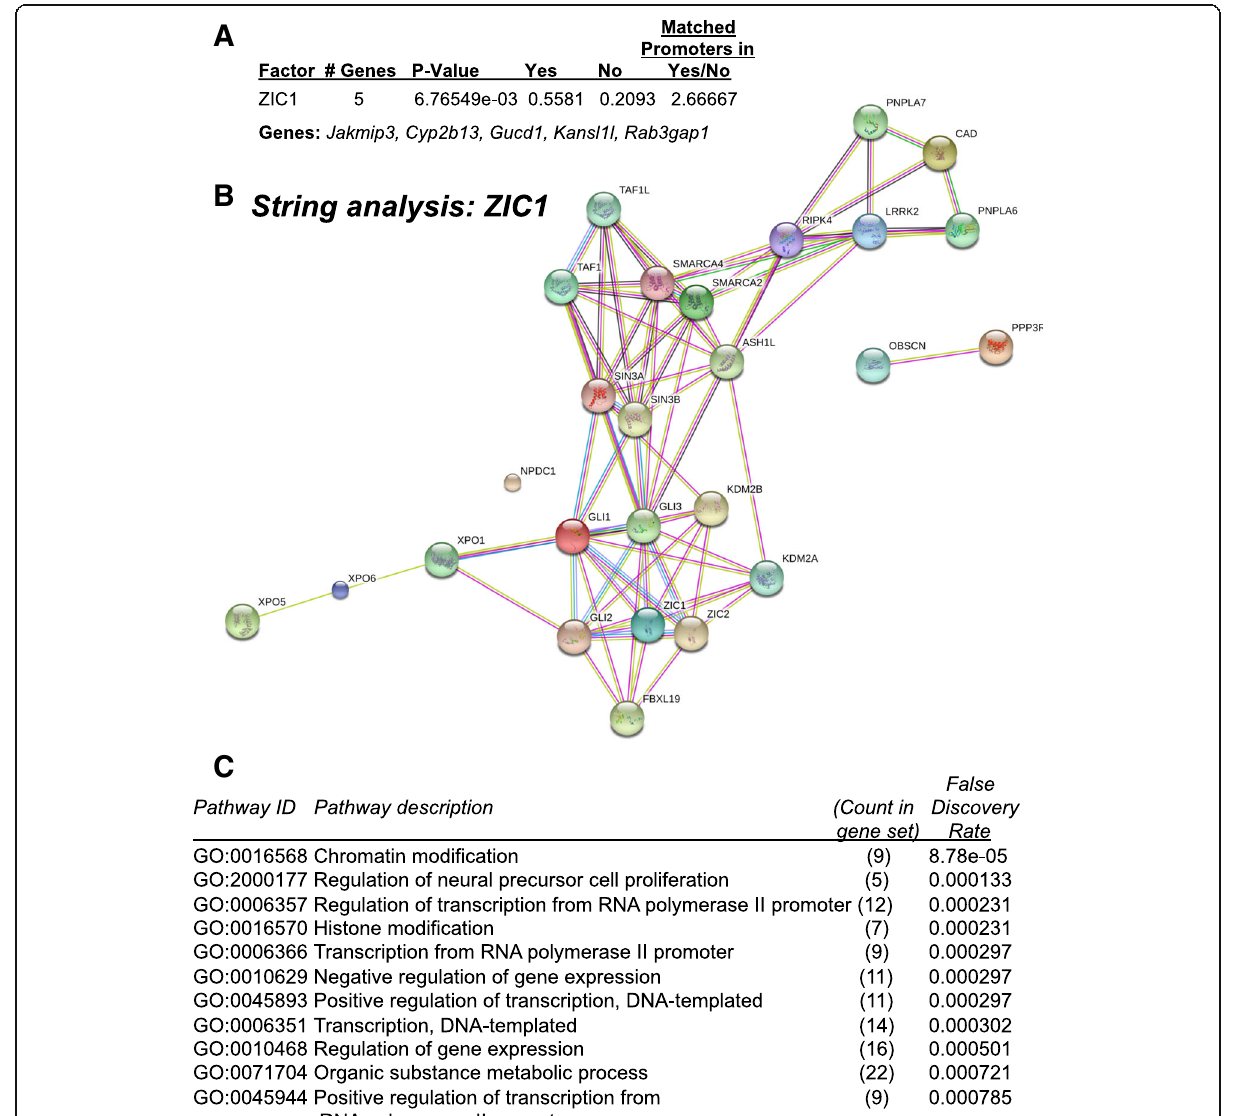
Fig. 4 Functional annotation of differentially expressed genes in MuRF1 Tg + right ventricles after three weeks CH exposure. a. Identification of ZIC1 protein binding sites based on binding sites in 5 of the differentially expressed genes in MuRF1 Tg+heart ( Jakmip3, Cyp2b13, Gucd1, Kansl1l, Rab3gap1 ). The number of genes in dataset and enrichment (sites/sequence ratio) for each transcription factor is calculated to the right. b. STRING analysis of the top 27 genes increased (>3-fold) and top 18 genes decreased (< − 3-fold) listed in Fig. 3b. c. Functional annotation of differentially expressed MuRF1 Tg+right ventricle by STRING